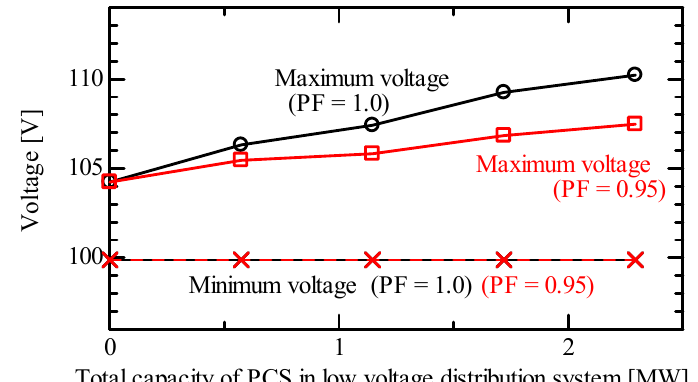
Figure 18. Maximum and minimum voltage of the LV distribution system connected to the MV distribution feeder as a function of capacity of PCS in the LV distribution system.